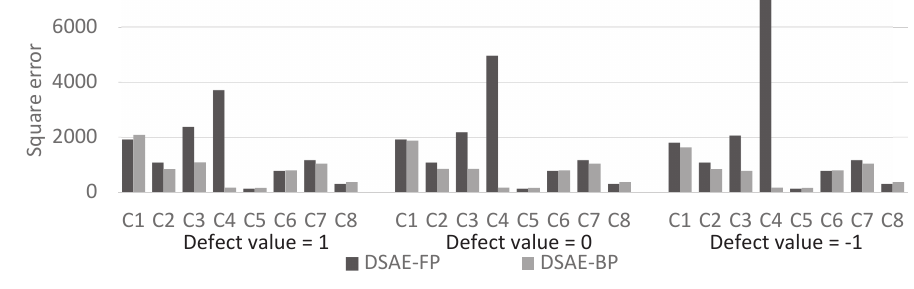
Figure 12. Convergence values of squared error with different initial value for each of the datasets when DSAE-FP and DSAE-BP were